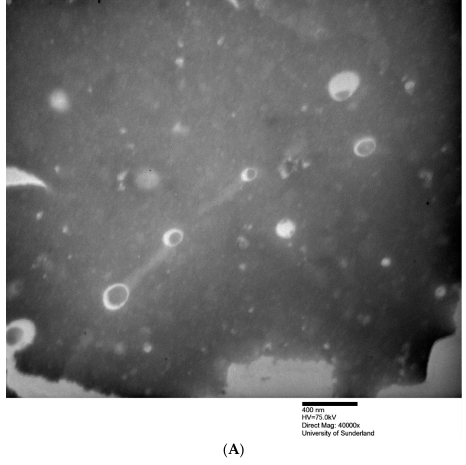
Table 2. Final lipid content (mg/mL) and entrapment efficiency (%EE) of methylene blue-loaded niosomal formulations. Formulation